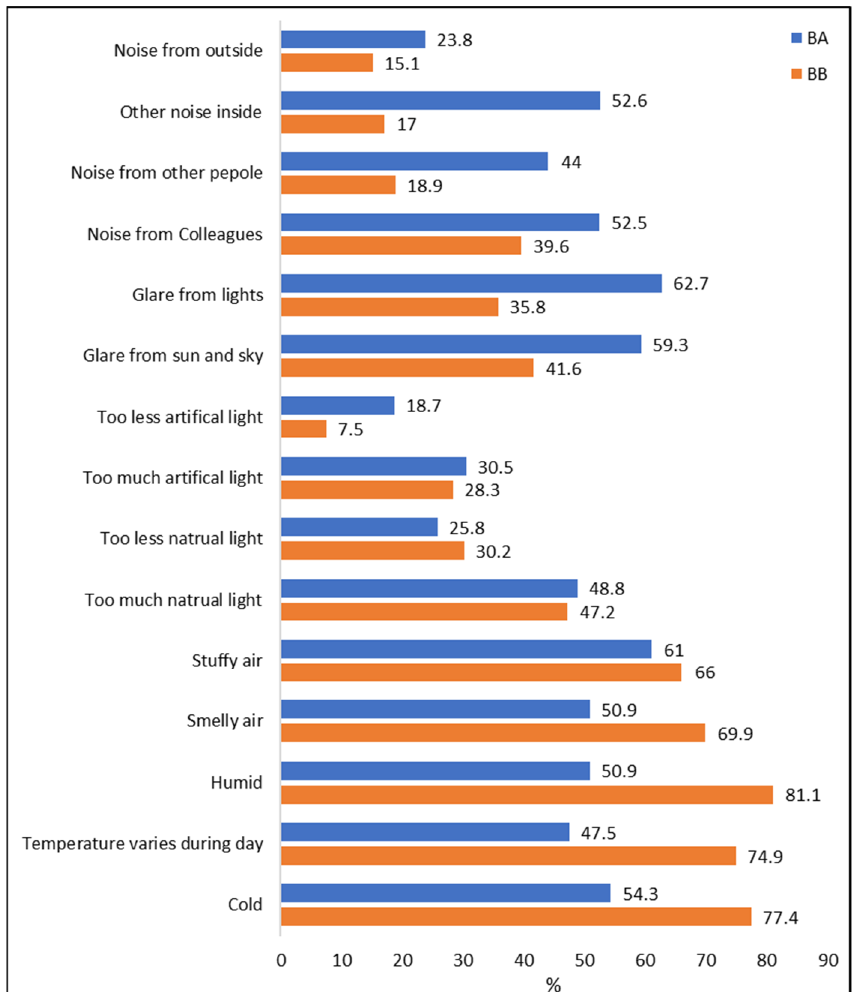
Figure 6. Comparison between the frequency of votes to the IEQ parameters contributing to uncomfortable and neural sensation.